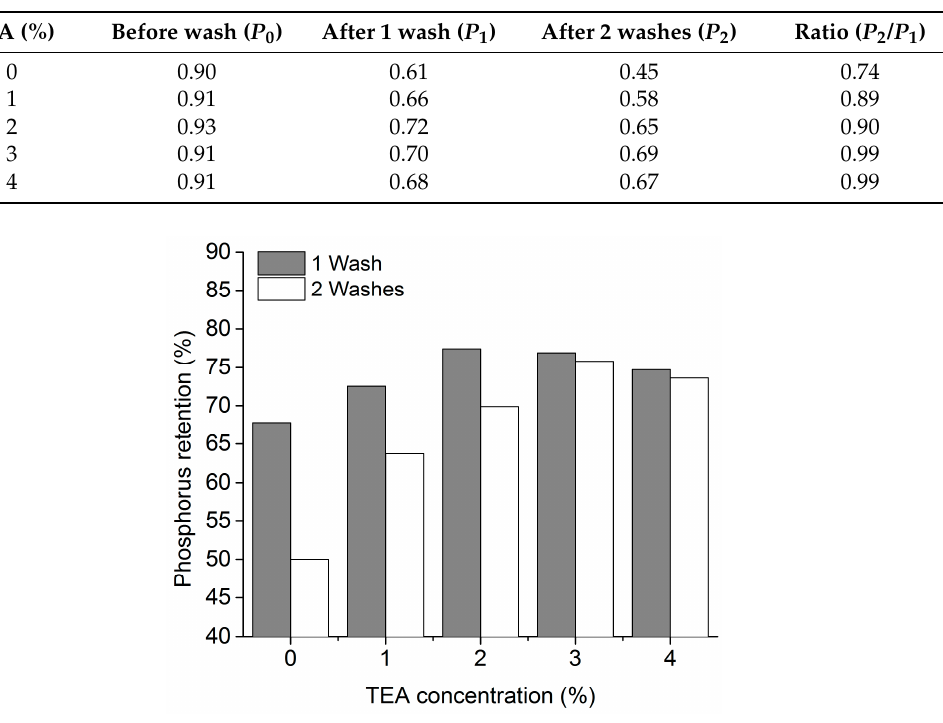
Figure 6. The phosphorus retention (%) of the Nomex ® /cotton fabric treated with 12% HFPO, 3% BTCA and TEA with different concentrations, cured at 170 °C for 3 min and subjected to one regular wash followed by a second wash with 0.01% Ca(NO 3 ) 2 added.